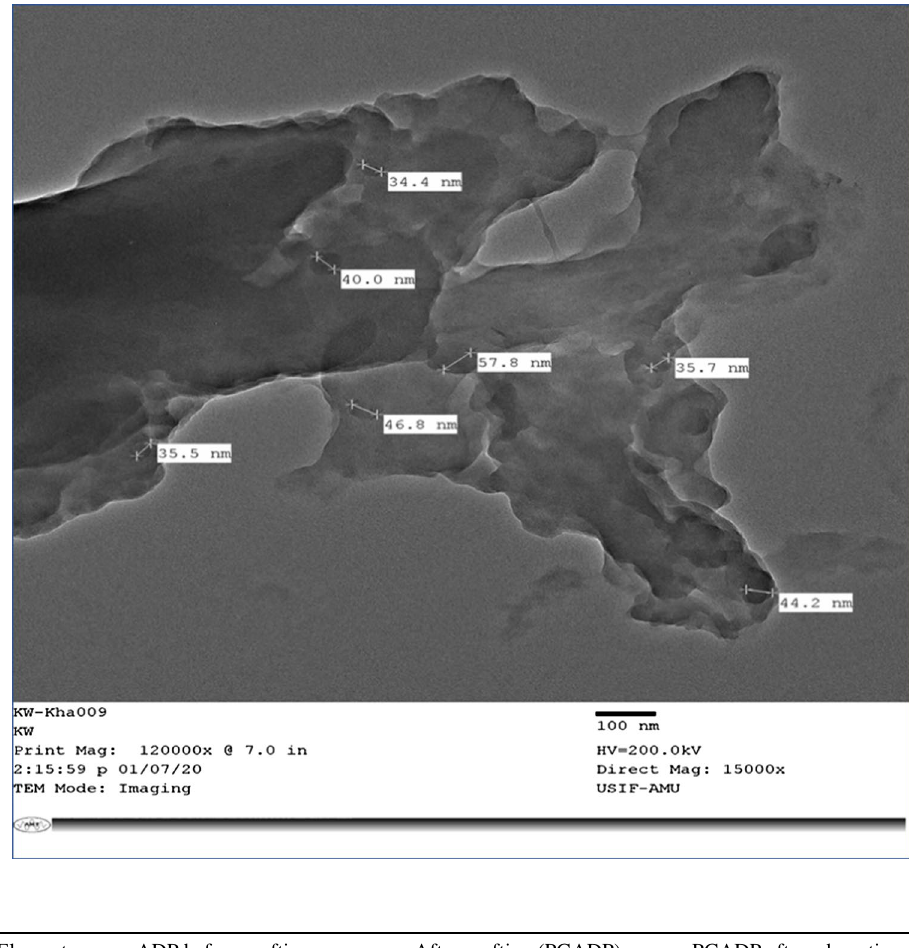
Fig. 2 TEM micrograph of